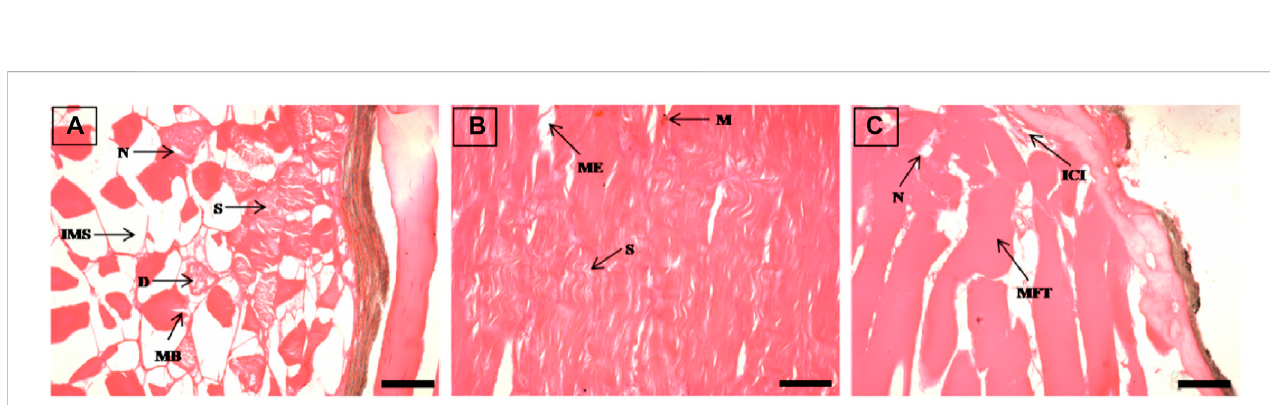
FIGURE 3 The histological sections(4 µm)of muscletissues fromEB-administered golden mahseer on11th day (A – C) ofEB-medication. Thehistologicalchanges in muscle tissues of fi shes fed with EB doses (A) at 100 μ g/kg fi sh/day showing degeneration of muscle bundles (D), splitting of myo fi brils (S), broken muscle bundles (MB), increased inter muscular space (IMS), necrosis (N); (B) at 250 μ g/kg fi sh/day showing muscular oedema (ME), severe splitting of myo fi brils (S), melanomacrophages (M); (C) at 500 μ g/kg fi sh/day showing necrosis (N), muscle fi bres thickening (MFT), in fl ammatory cells in fi ltration towards broken myo fi brils(ICI).TheH&Estainedsectionsarevisualizedatmagni fi cationof×400underinvertedlightmicroscope(OlympusIX53,Canada).Thescalebarvalue depicted in the right bottom corner (A – C) is 20